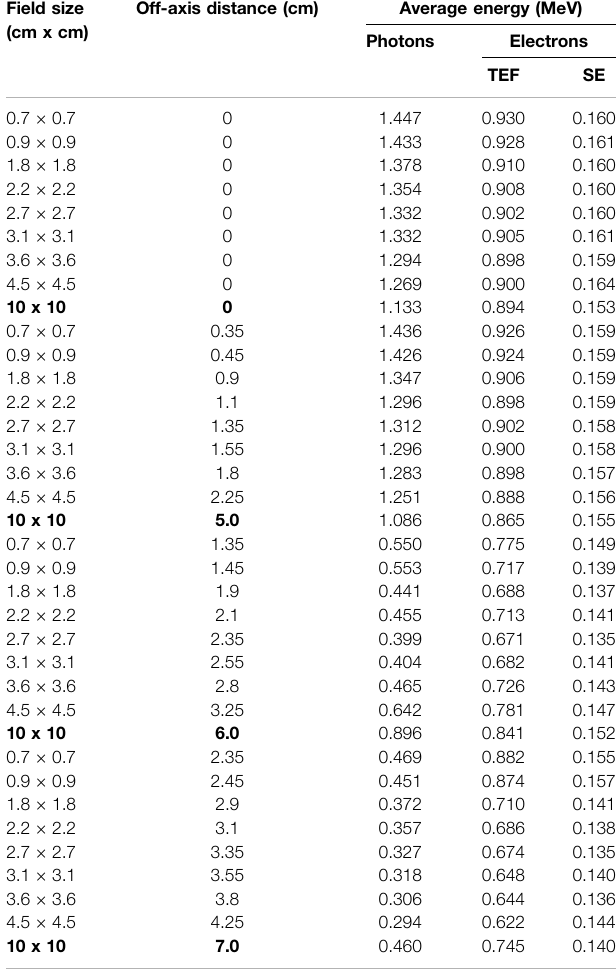
The bold indicates the end of each distance from the edge of the fi